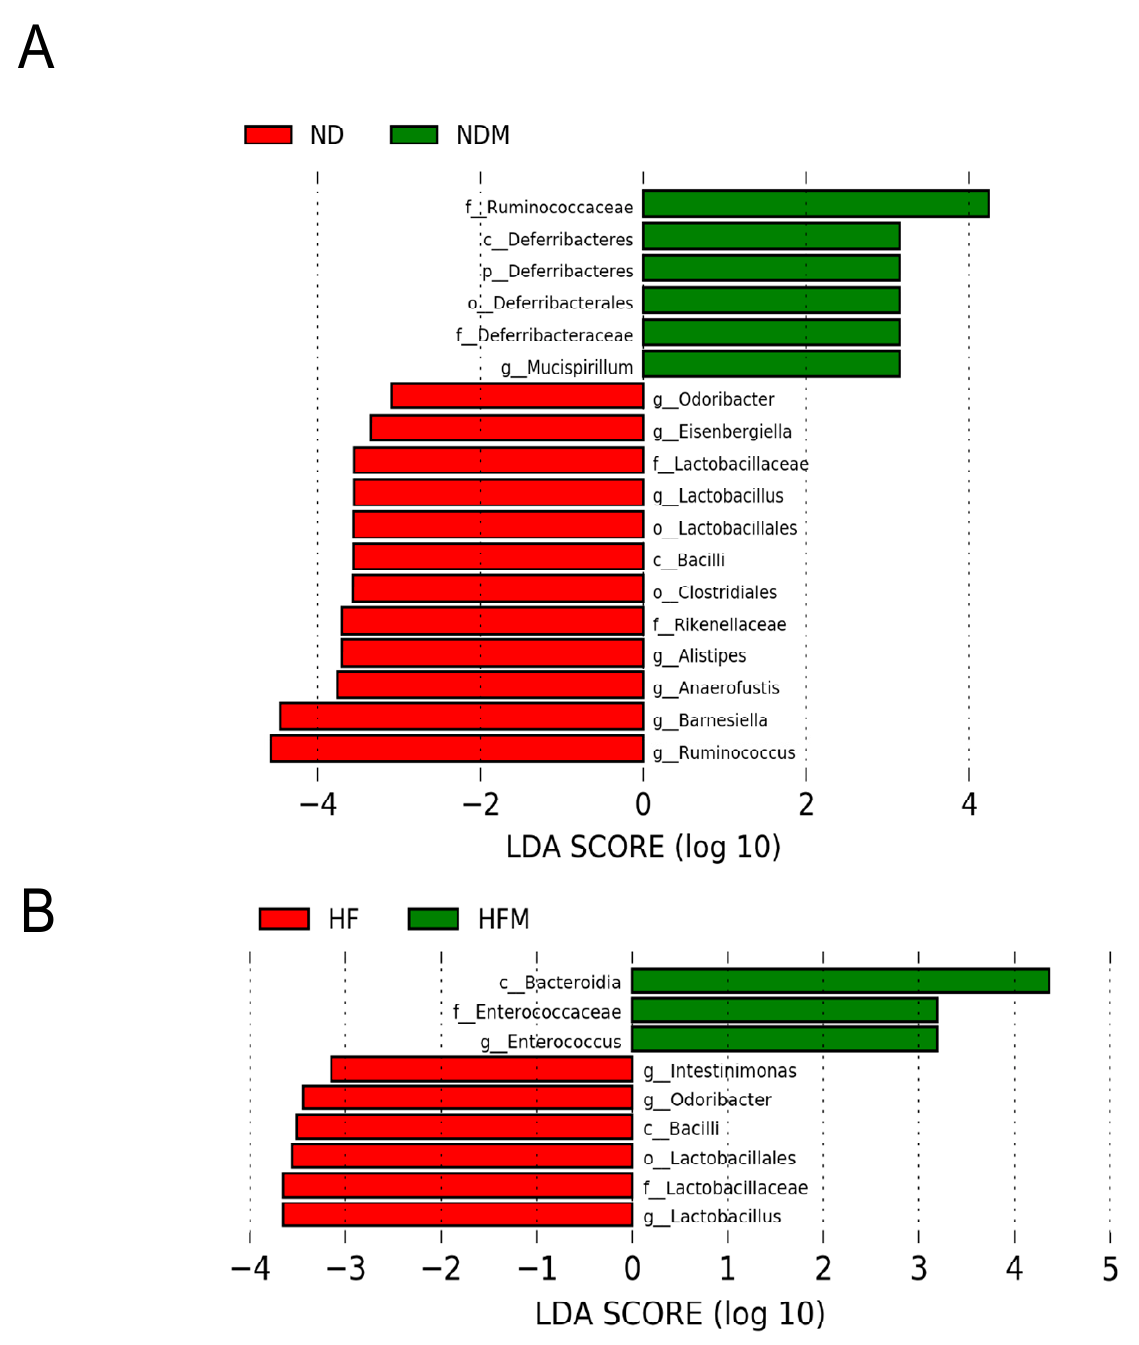
Figure 5. Effect of high-fructose diet (HF) and minocycline administration (M) on the gut microbiome in male 12-week-old male offspring. Linear discriminant analysis effect size (LEfSe) was applied for biomarker discovery in metagenomic data. Most enriched and depleted bacterial taxa in the ( A ) ND (red) versus NDM group (green) and ( B ) HF (red) versus HFM group (green) are shown. Different taxonomic levels of bacteria are given reaching from phylum down to genus-level. Each name is preceded by a letter giving the rank: p = phylum, c = class, o = order, f = family, g = genus. The threshold on the linear discriminant was set to 3.